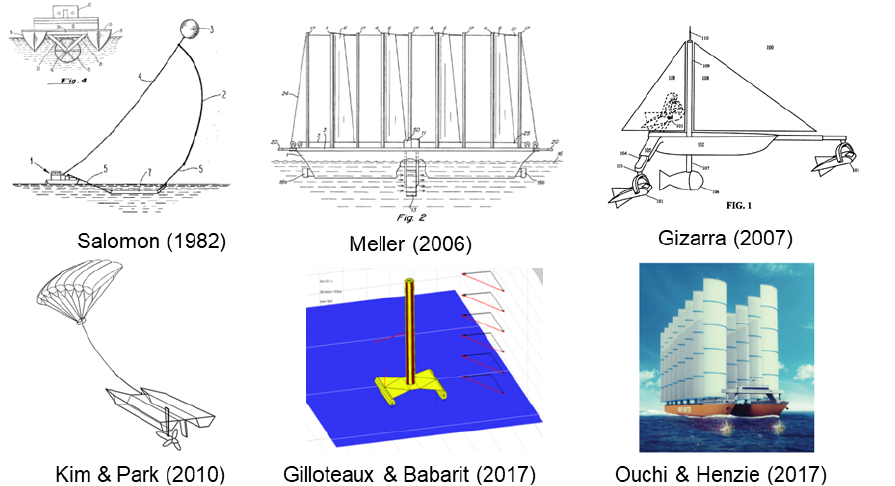
Figure 1. Pictures of technology proposals of energy ships.